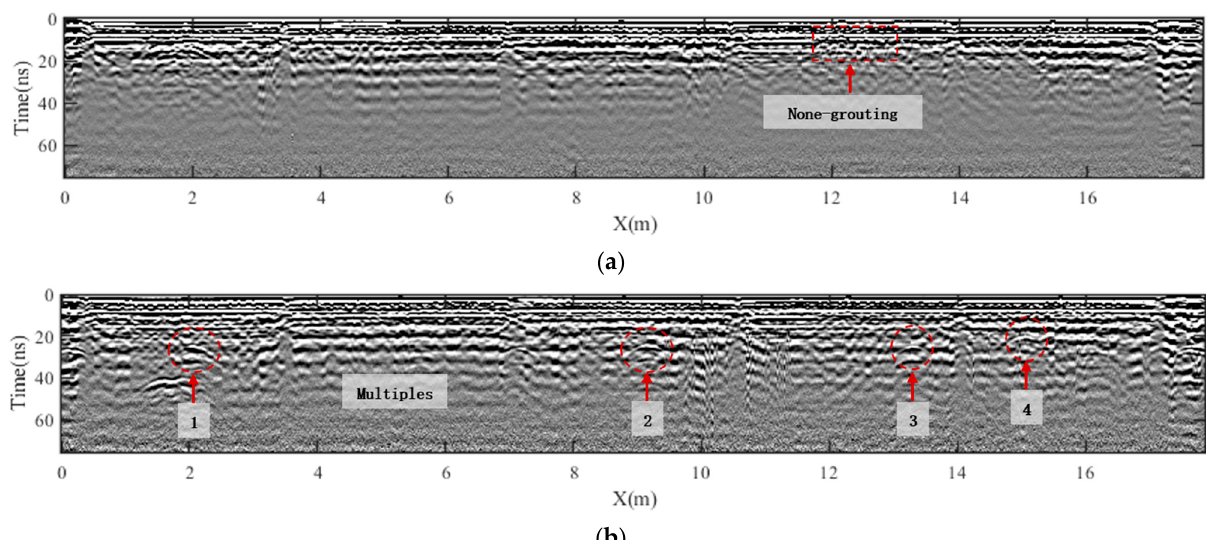
Figure 4. Test results for different filling materials. ( a ) Defects filled with air; ( b ) Defects filled with water.